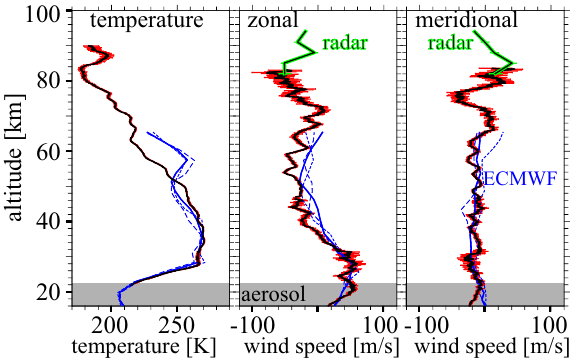
Fig. 10. Temperature and horizontal wind on 23 January 2009 be- tween 17:00 and 19:00UT. More details in Fig.